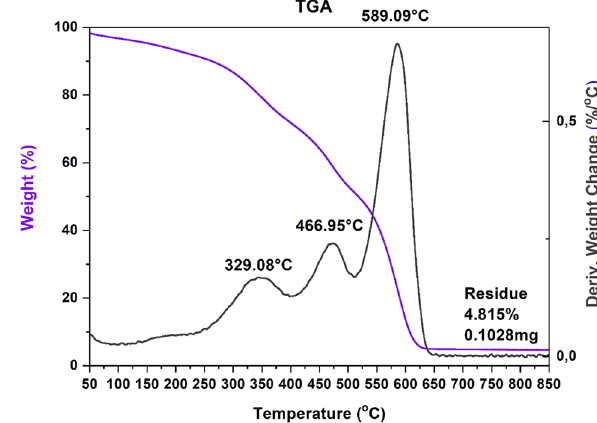
Figure 8: TGA thermogram for unmodi fi ed CNTs after puri fi cation processes.